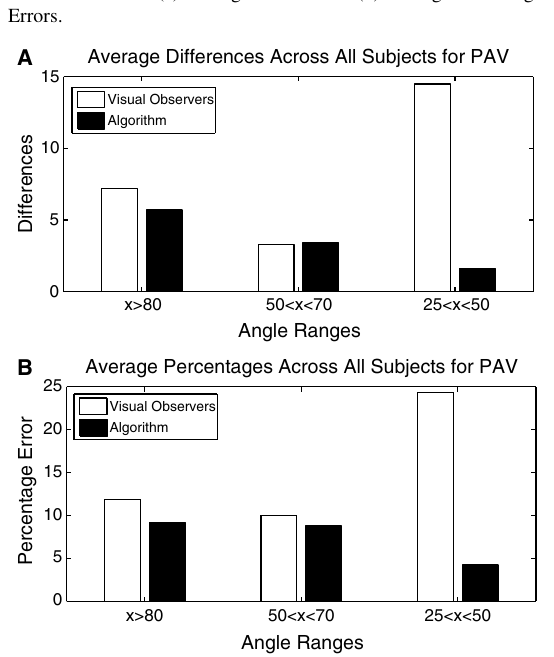
Fig. 12. Comparison between the expert users and algorithm, with respect to the ground truth data, of the averages across all subjects for the PAV data. (a) Average Differences. (b) Average Percentage